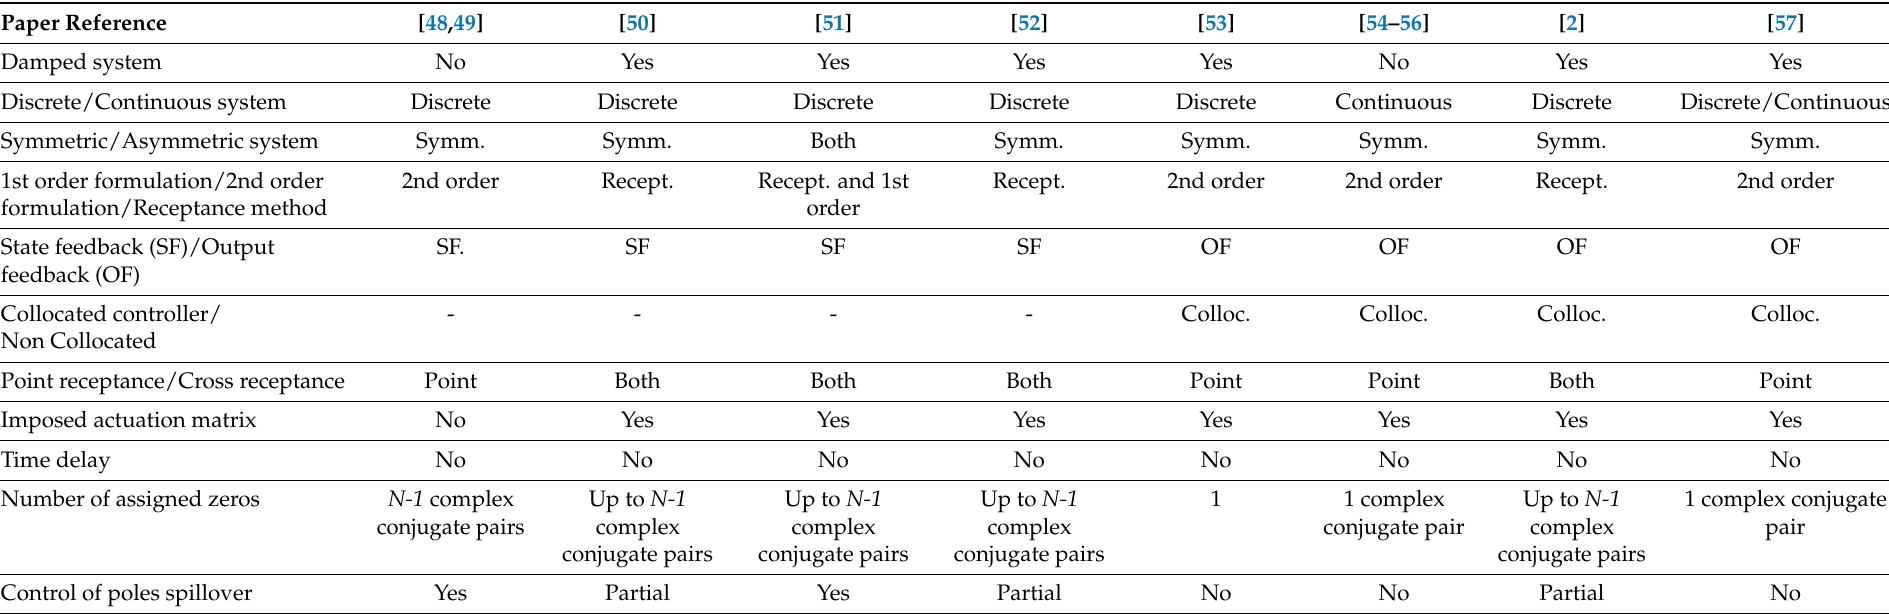
Table 3. Active antiresonance assignment control techniques: a comparison of existing